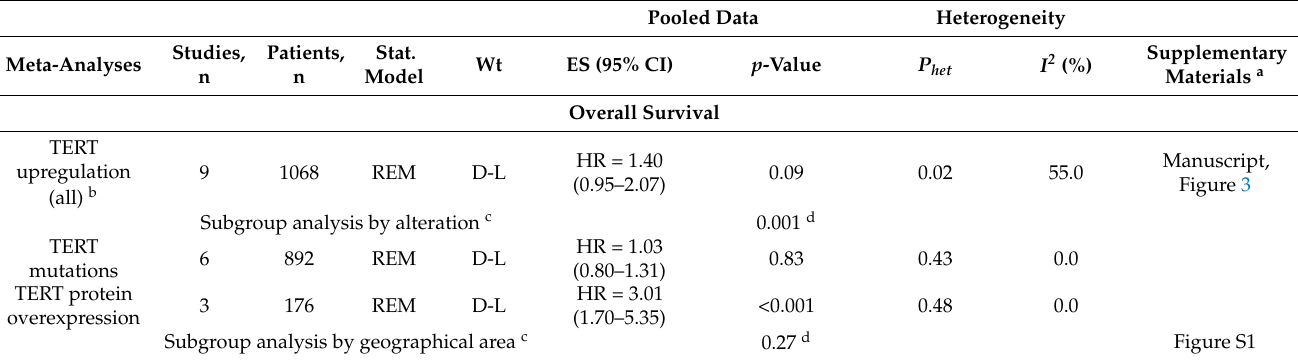
Table 2. Meta-analyses of prognostic and clinicopathological significance of TERT upregulation in